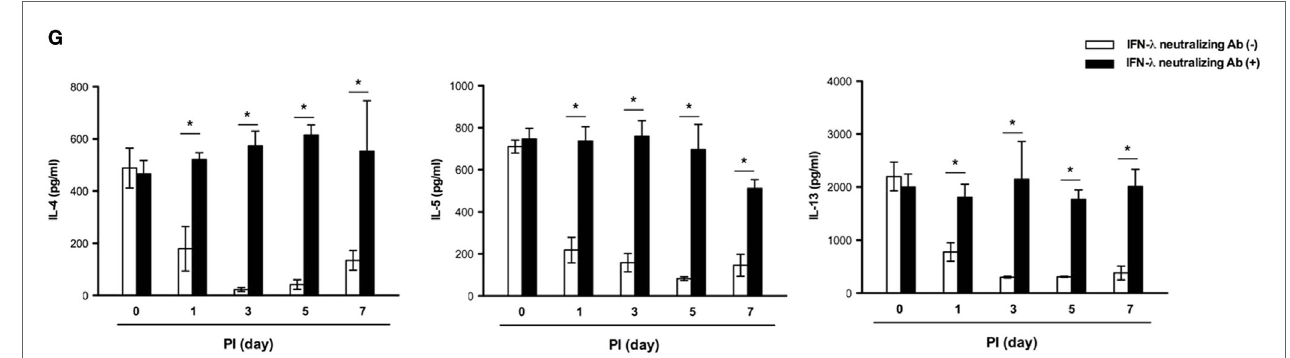
FigUre 4 | Acute influenza A virus (IAV) infection is aggravated in asthmatic mice administered neutralizing antibodies against interferon (IFN)- λ 2/3 and IFN- γ . Asthmatic mice with isotype-control (rat IgG) antibodies were infected with 213 pfu IAV WS/33 (H1N1) ( N = 5) and treated with neutralizing antibodies against IFN- λ 2/3 ( N = 5) or IFN- γ ( N = 5). Hematoxylin/eosin (H&E)-stained micrographs were generated from lung sections obtained from IAV-infected asthmatic mice on day 7 (a) . Viral titer (B) and secreted IFN level (c,D) were determined by plaque assay and enzyme-linked immunosorbent assay. Histological assessment